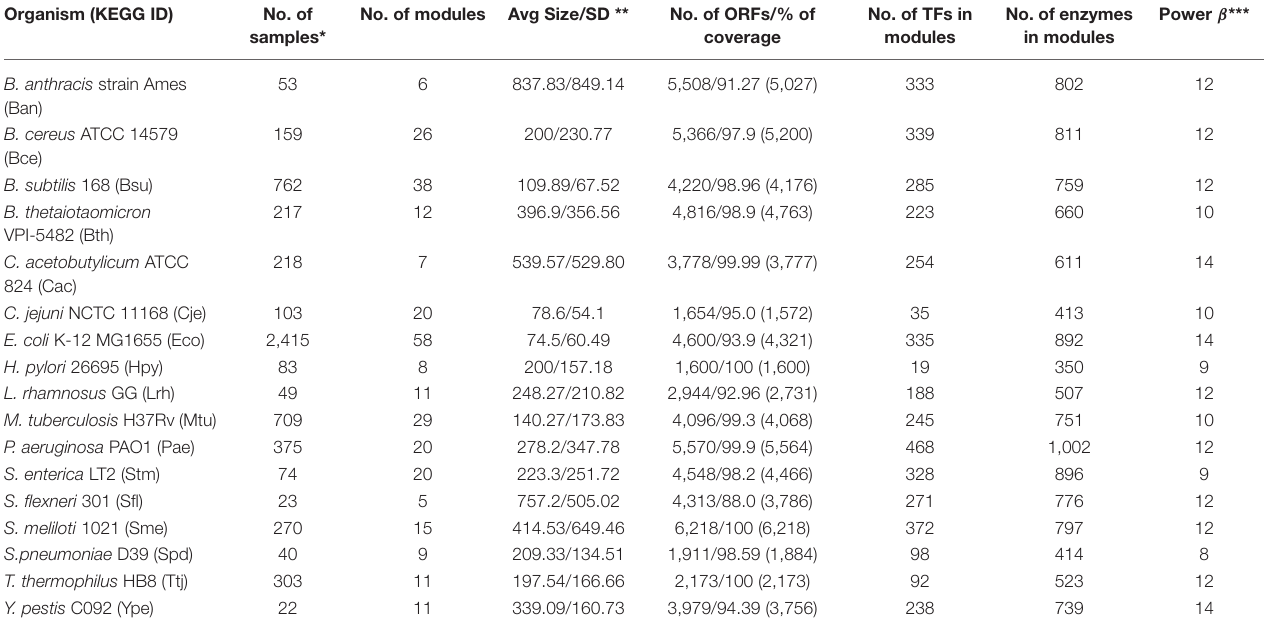
TABLE 1 | Overview of dataset and co-expression modules in this study. Organism (KEGG ID)